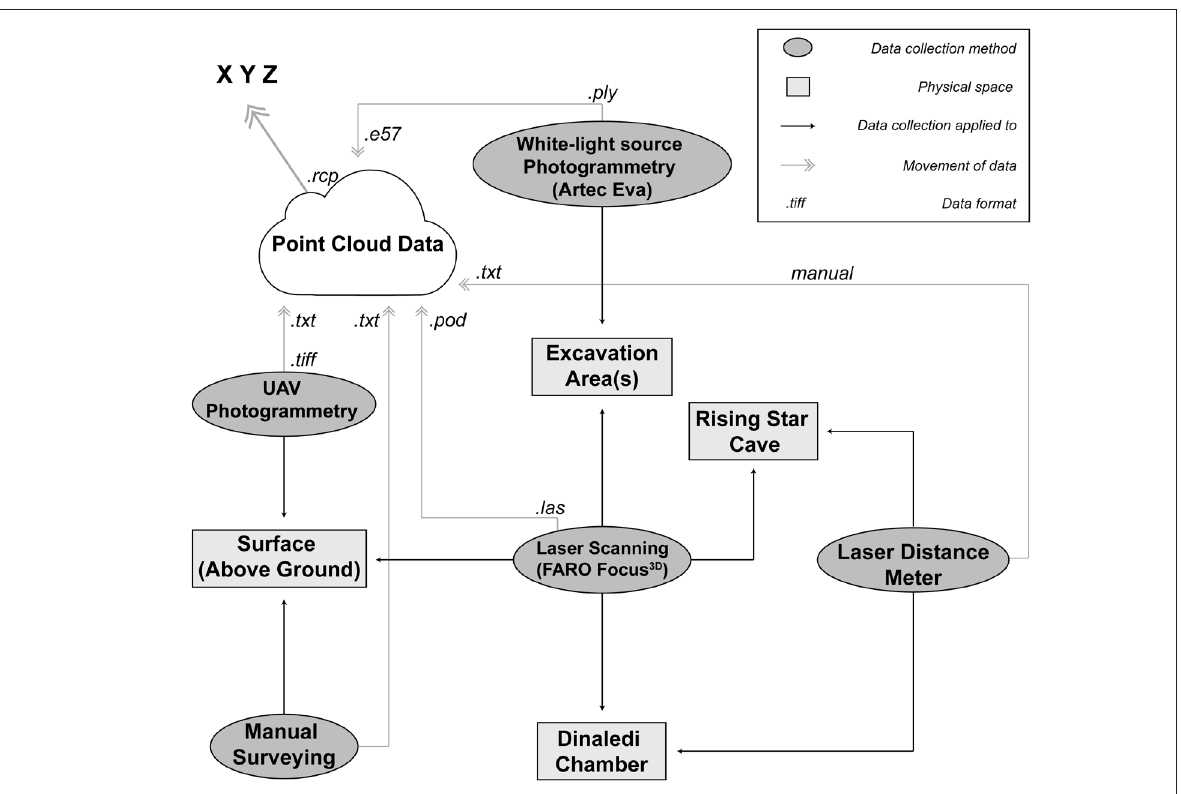
Figure 5: Workflow of the data collection techniques, data formats and structures employed to acquire high-resolution data at the Rising Star